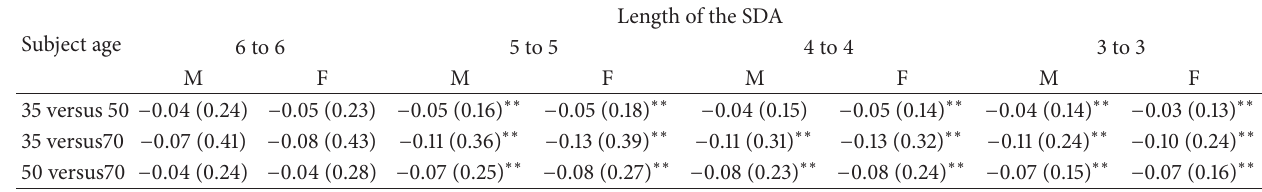
Table 4: Mean difference and standard deviation of the mean difference for paired 𝑡 -test to examine the impact of subject age on dentists’ attitudes towards SDAs.